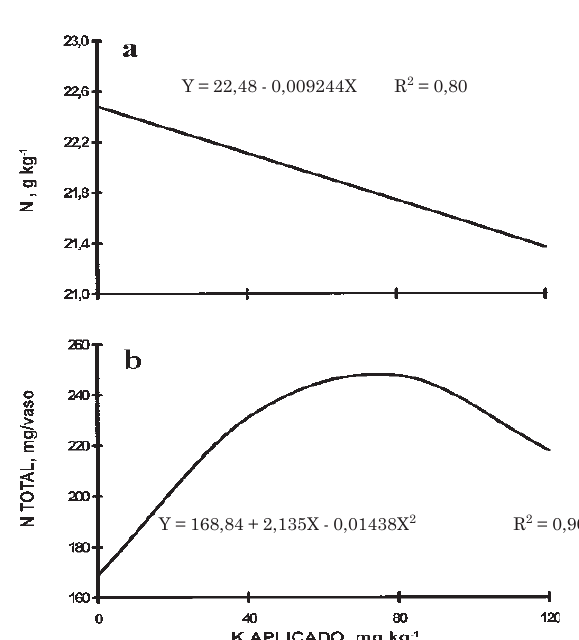
Figura 6. Concentração (a) e quantidade total (b) de nitrogênio nas raízes da alfafa, em função das doses de